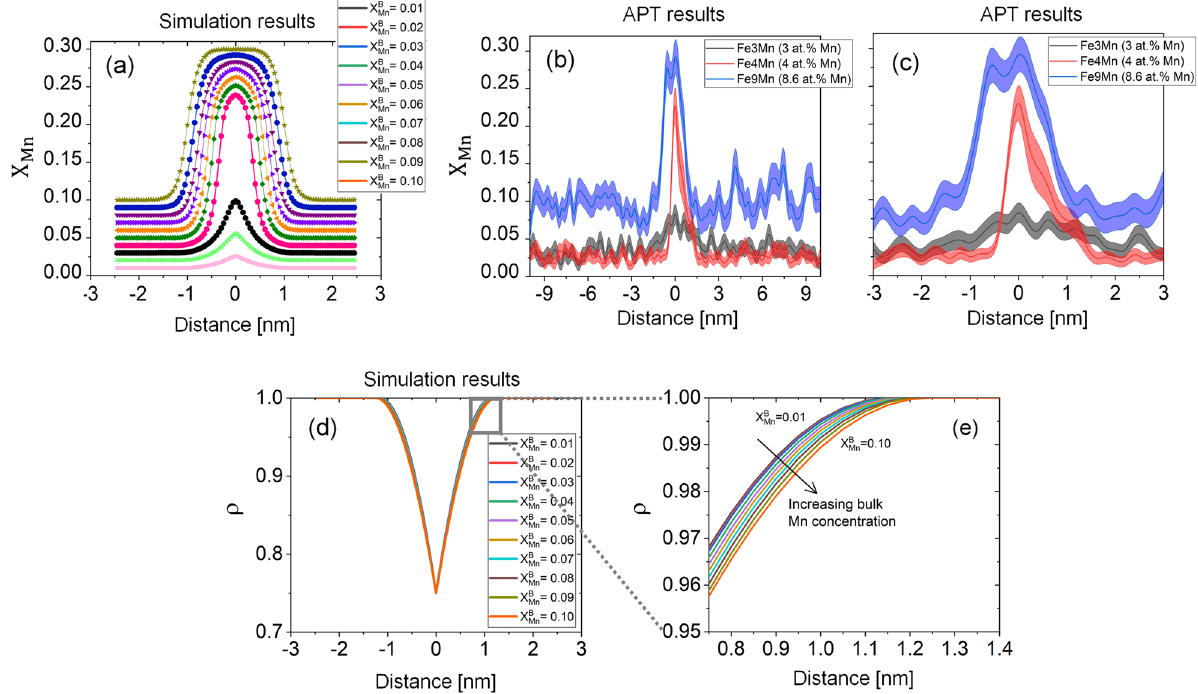
Fig. 3 Equilibrium GB concentration and density pro fi les. a Mn concentration pro fi les are shown for different bulk compositions (1D calculations). An atomic GB density ρ GB = 0.75 and a gradient energy coef fi cient κ X = 5 × 10 − 18 J m 2 mol − 1 were used in these calculations. b , c Concentration pro fi les with corresponding error bars obtained from the APT measurements for three different Fe – Mn alloys with 3.0, 4.0, and 8.6 at.% Mn (Fe3Mn, Fe4Mn, and Fe9M, respectively). b is magni fi cation of ( c ) along the x axis. A jump in the GB segregation occurs for an alloy composition between 3.0 and 4.0 at.% Mn that is con fi rmed by APT measurements. d , e Equilibrium density pro fi les for different bulk compositions, corresponding to the concentration pro fi les in ( a ). For higher segregation levels, the GB width increases.